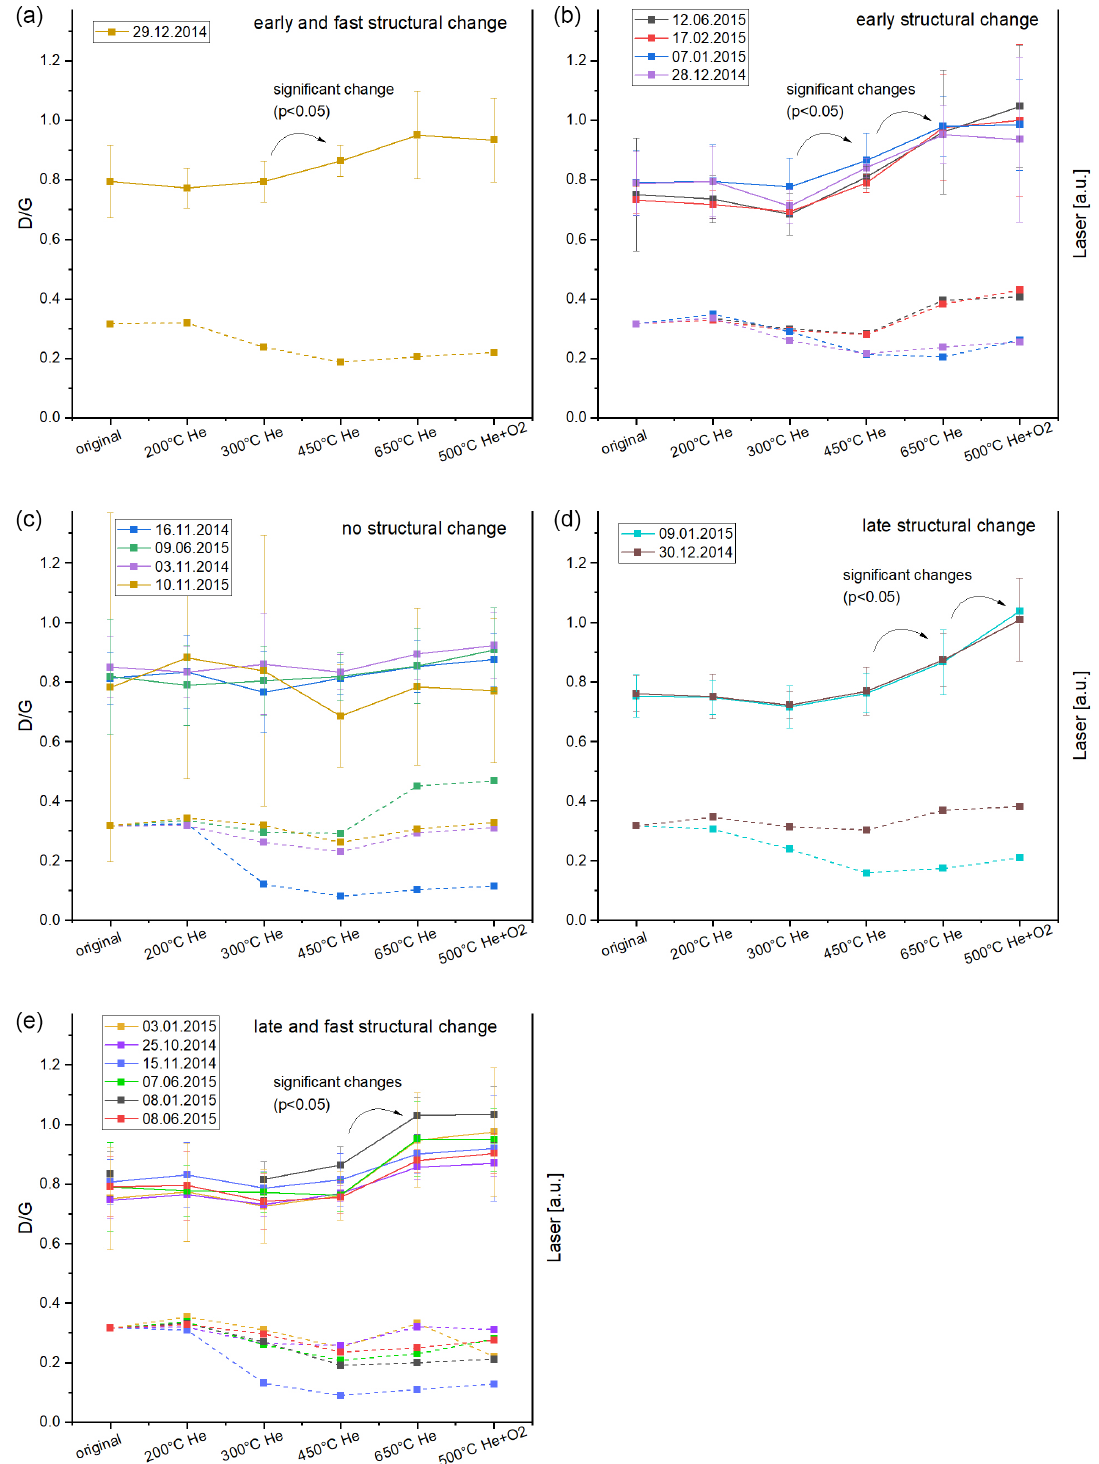
Figure 6. Comparison of the changes of D/G peak ratios (solid lines, left axis) and transmission laser signals (dashed lines, right axis) at the end of each temperature level sorted by Raman categories. Standard deviations of D/G are calculated from the standard deviations of the Raman spectra. All laser signals are normalized to the signal at the end of the measurement procedure (i.e., signal of the clean filter). The curves for the different filters are shifted at the y axis so that all curves start at the same point (original sample). It is visible that changes in D/G and changes in laser signal are not